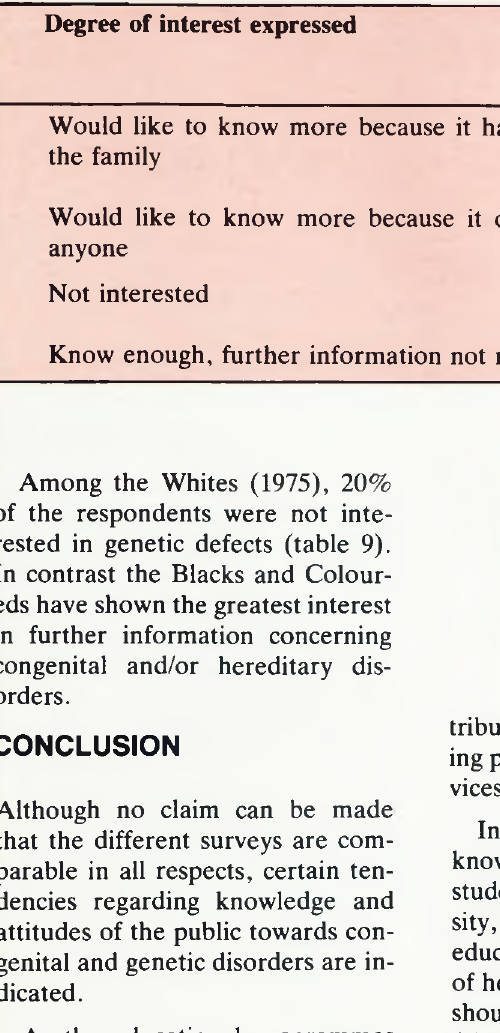
TABLE 9 Degree of interest expressed in information on genetic defects